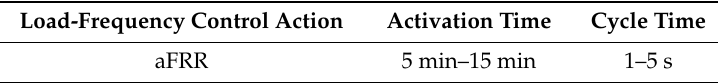
Table 2. Load-frequency control technical requirements [41].